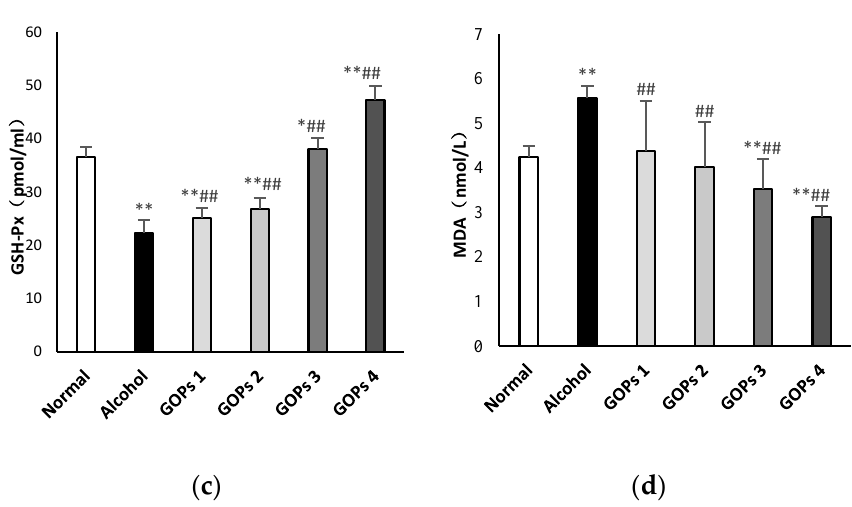
Figure 2. Effects of GOPs on hepatic SOD ( a ), GSH ( b ), GSH-PX ( c ), MDA ( d ) levels in alcohol-induced rats. Data represent the mean ± SD ( n = 10). Significant differences were indicated by * p < 0.05 versus control group, ** p < 0.01 versus control group; # p < 0.05 versus alcohol group, ## p < 0.01 versus alcohol group. SOD, superoxide dismutase; GSH, reduced glutathione; GSH-Px, glutathione peroxidase;